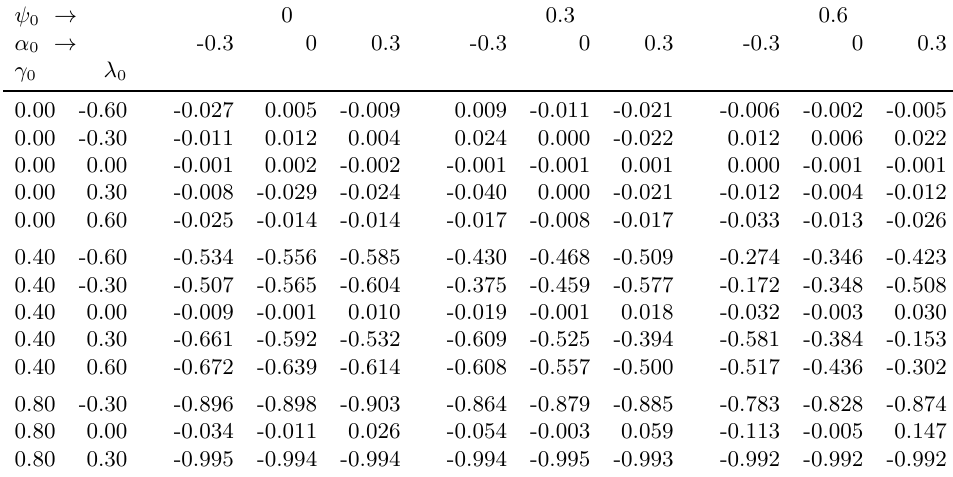
Table D.7: Bias of Team Spatial – marginal indirect long-run